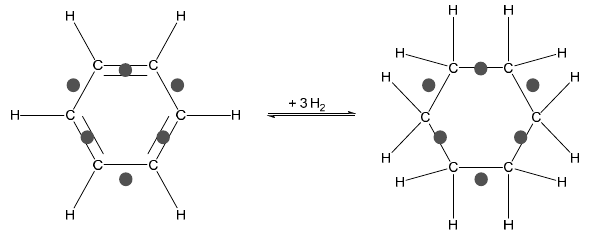
Figure 16. Schematic representation of the sextet mechanism of benzene hydrogenation and cyclo- hexane dehydrogenation at metal centers (gray dots) with hexagonal symmetry, such as found in platinum, palladium, and nickel following Balandin [25,27].